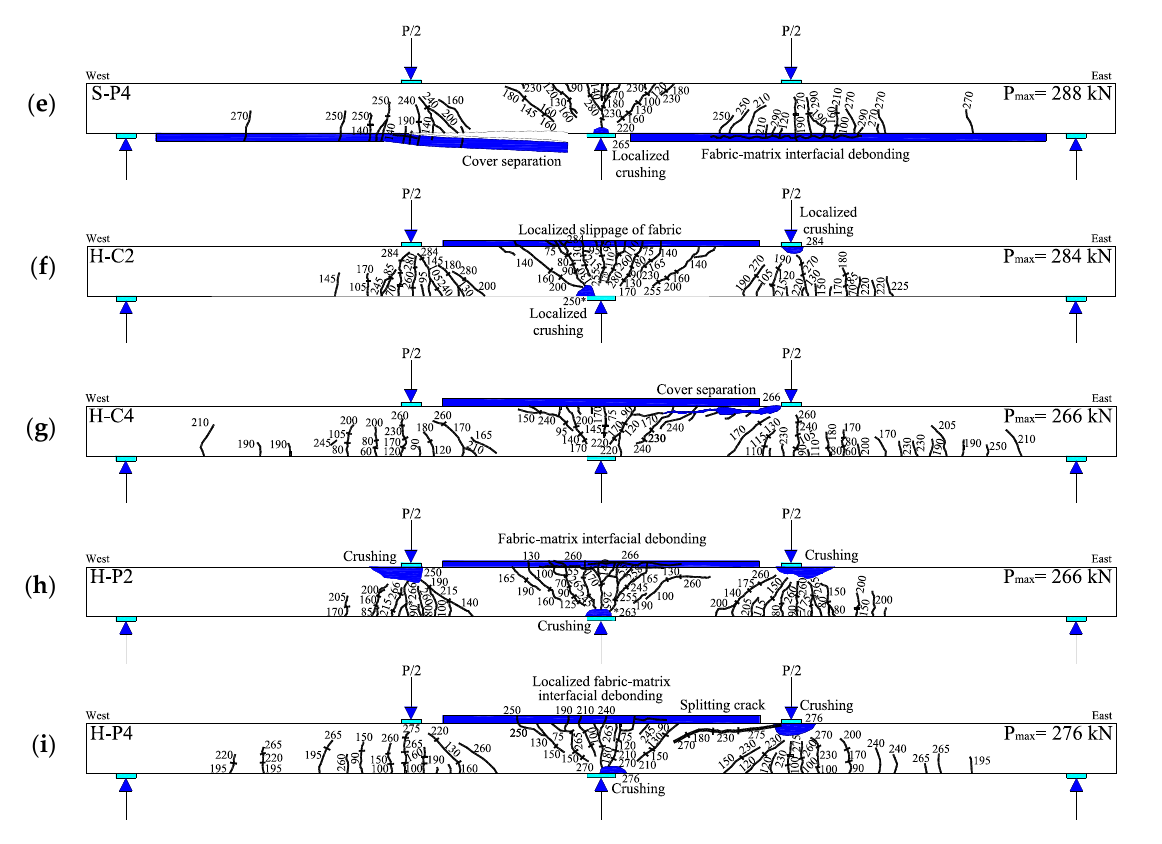
Figure 7. Crack pattern from the experiment (values are in kN): ( a ) Control; ( b ) S-C2; ( c ) S-C4; ( d ) S-P2;